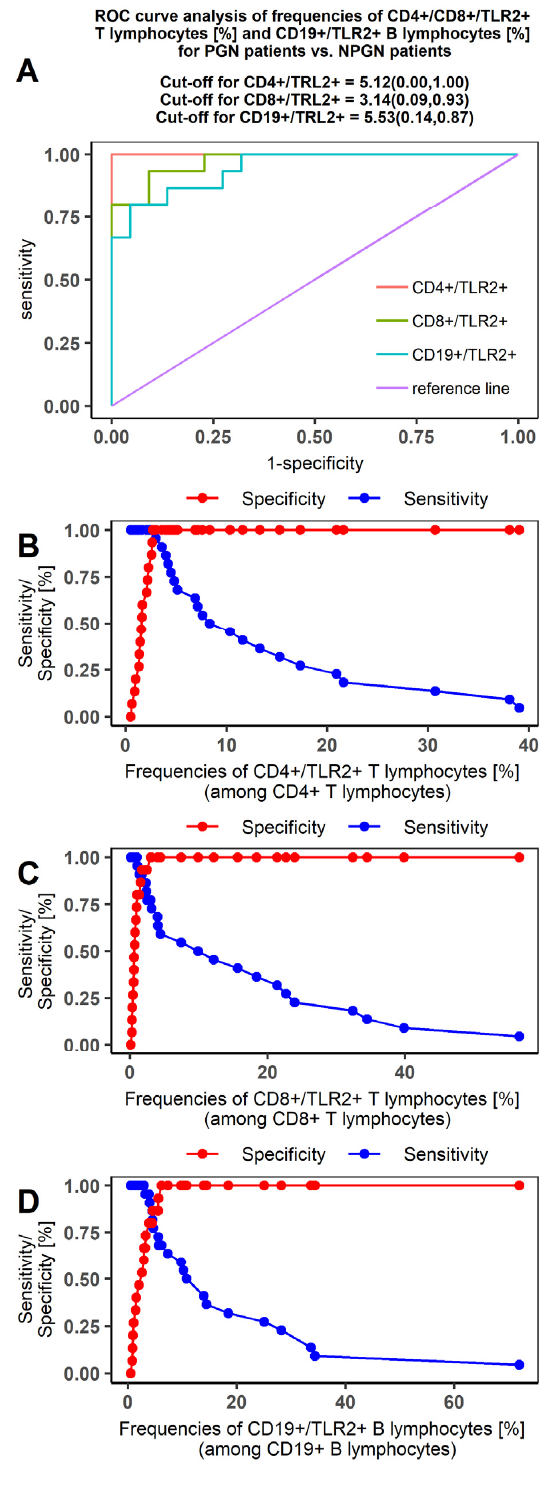
Figure 2. Receiver operating characteristic (ROC) curve analysis showing the sensitivity and specificity of TLR2 expression to distinguish between patients with non-proliferative (NPGN) and proliferative glomerulonephritis (PGN). ( A ) ROC curve analysis for CD4+/CD8+/TLR2+ T lymphocyte (%) and CD19+/TLR2+ B lymphocyte frequencies (%); ( B ) sensitivity/specificity curve for CD4+/TLR2+T lymphocytes (%); ( C ) sensitivity/specificity curve for CD8+/TLR2+ T lymphocytes (%); ( D ) sensitivity/specificity curve for CD19+/TLR2+B lymphocytes.